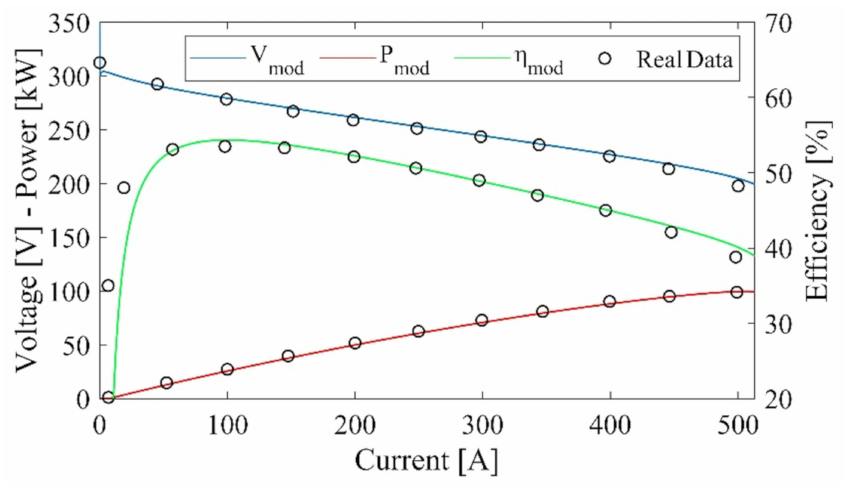
Figure 3. Fuel cell validation test.